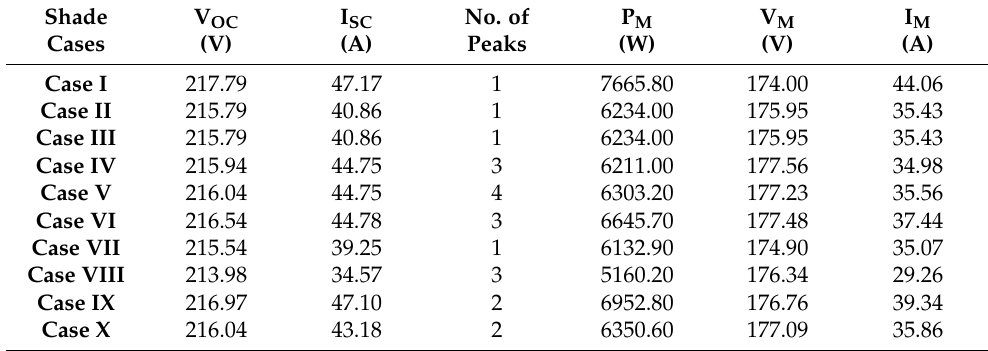
Table 6. NSD performance under